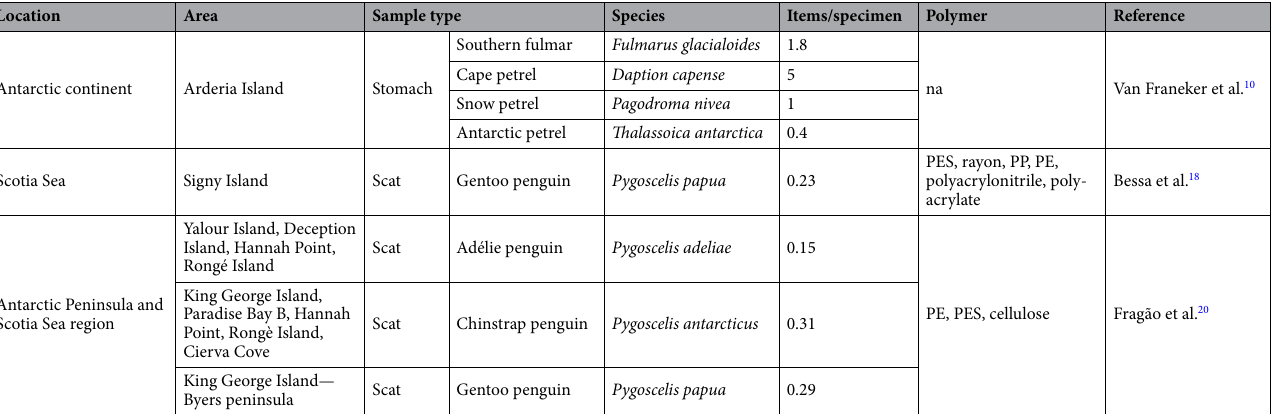
Table 2. Summary of anthropogenic microparticles concentrations in Antarctic vertebrates (below the sixtieth parallel). Polyester: PES, polypropylene: PP; polyethylene: PE.